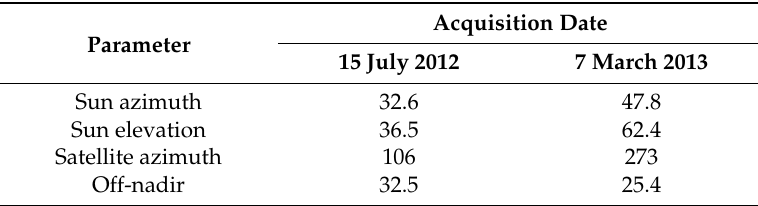
Table 1. Main characteristics of the March and July WorldView-2